Question: Reading the figure, is the described quantity rising or falling?
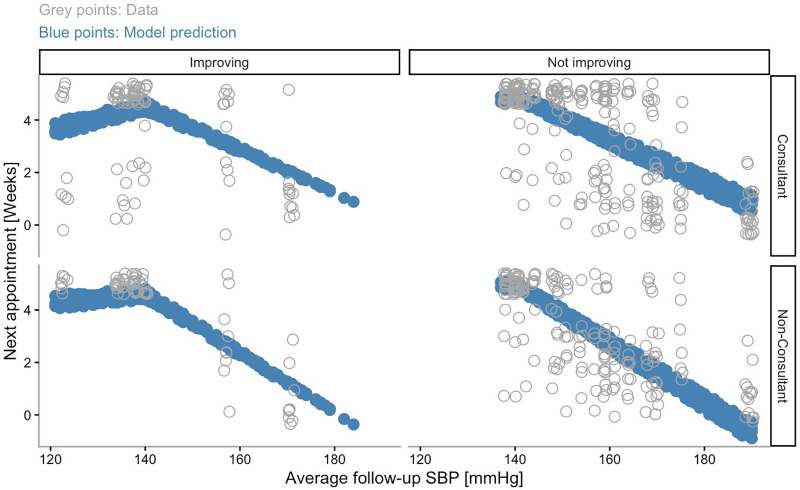
Answer: increasing